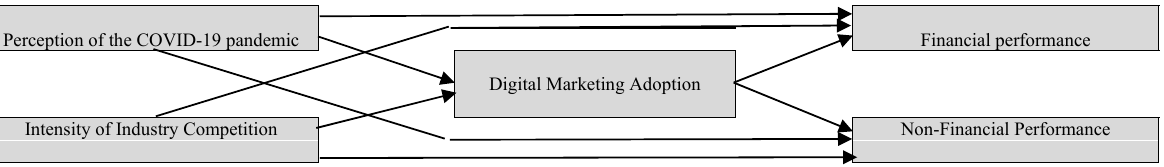
Fig. 1. Conceptual